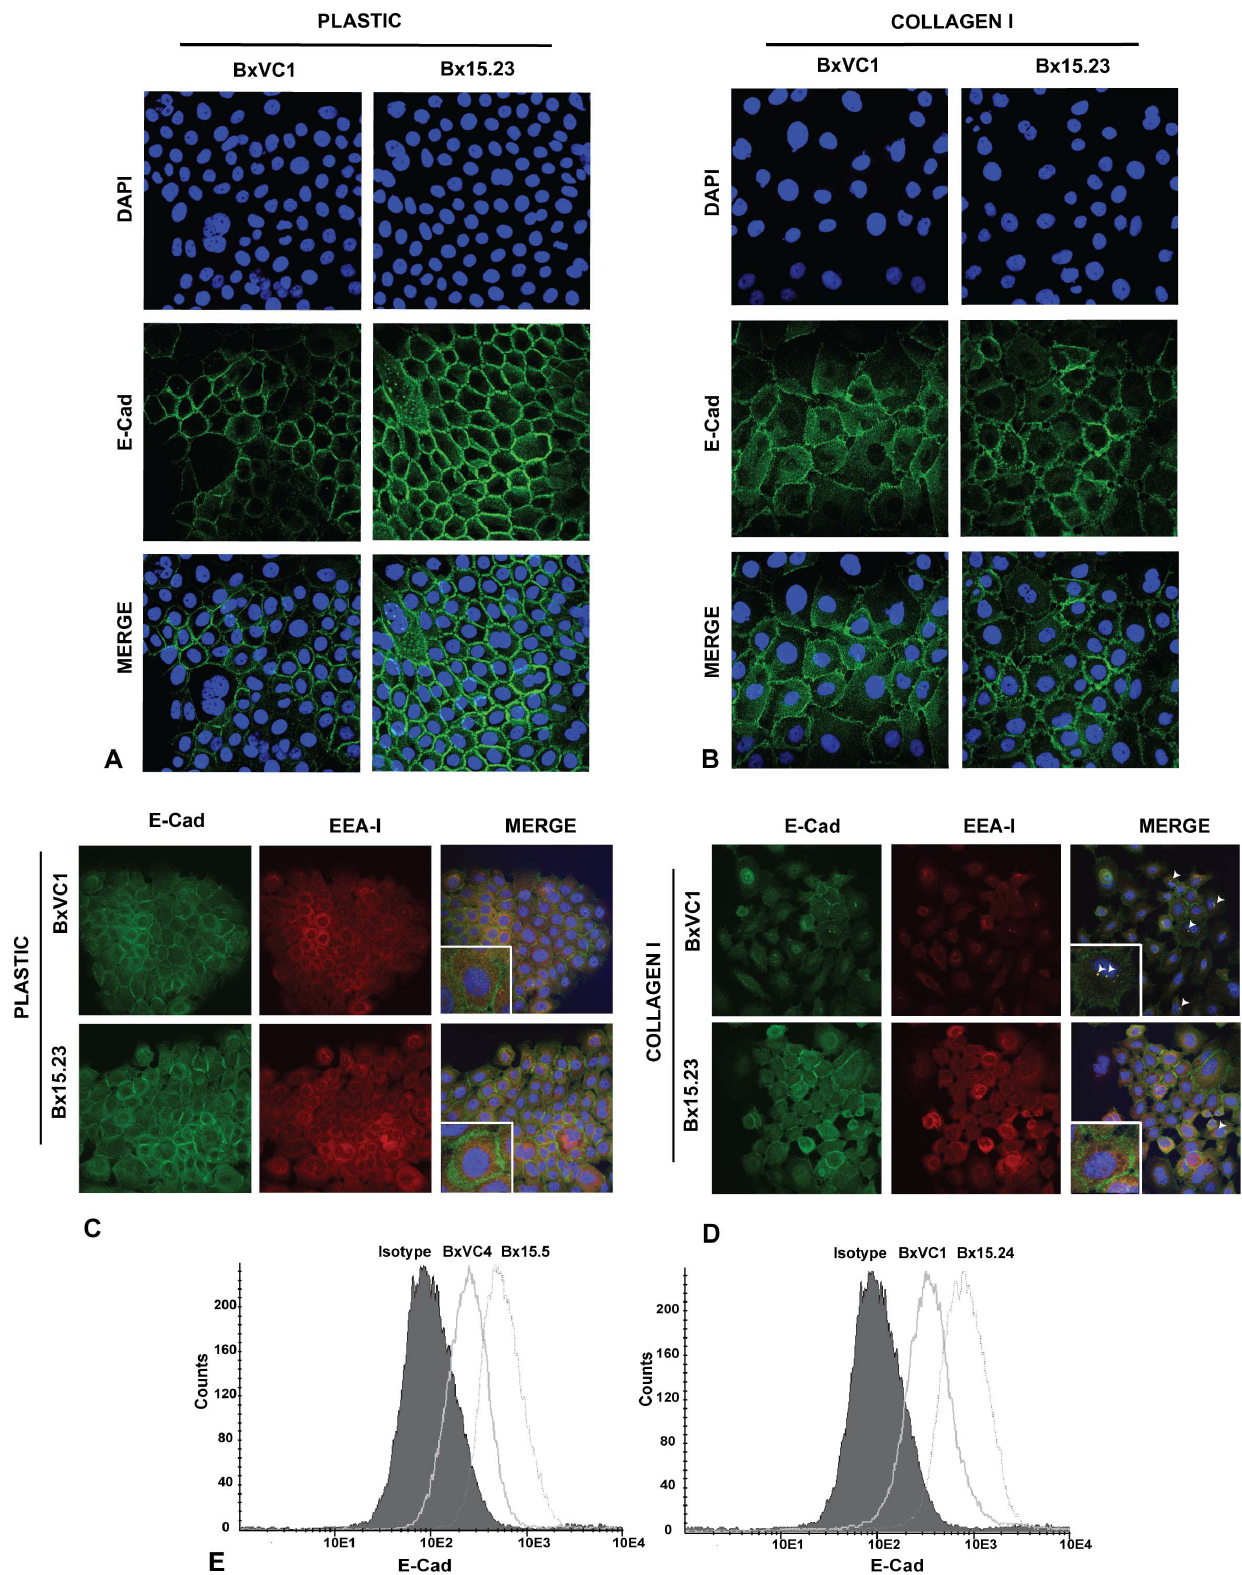
Figure 3. E-Cadherin is stabilized at the cell periphery in collagen XV expressing cells. Confocal microscopy with an antibody specific for the extracellular domain of E-Cad (green) and nuclei stained with DAPI (blue). BxVC1 vector clone and Bx15.23 COLXV clone grown on plastic A) or COLI B). E-Cad is most abundant at the cell surface in both clones on plastic. On COLI, E-Cad moves from the cell periphery into the cytoplasm in